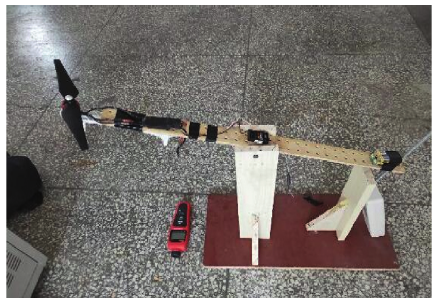
Figure 9: Simple lift test device.